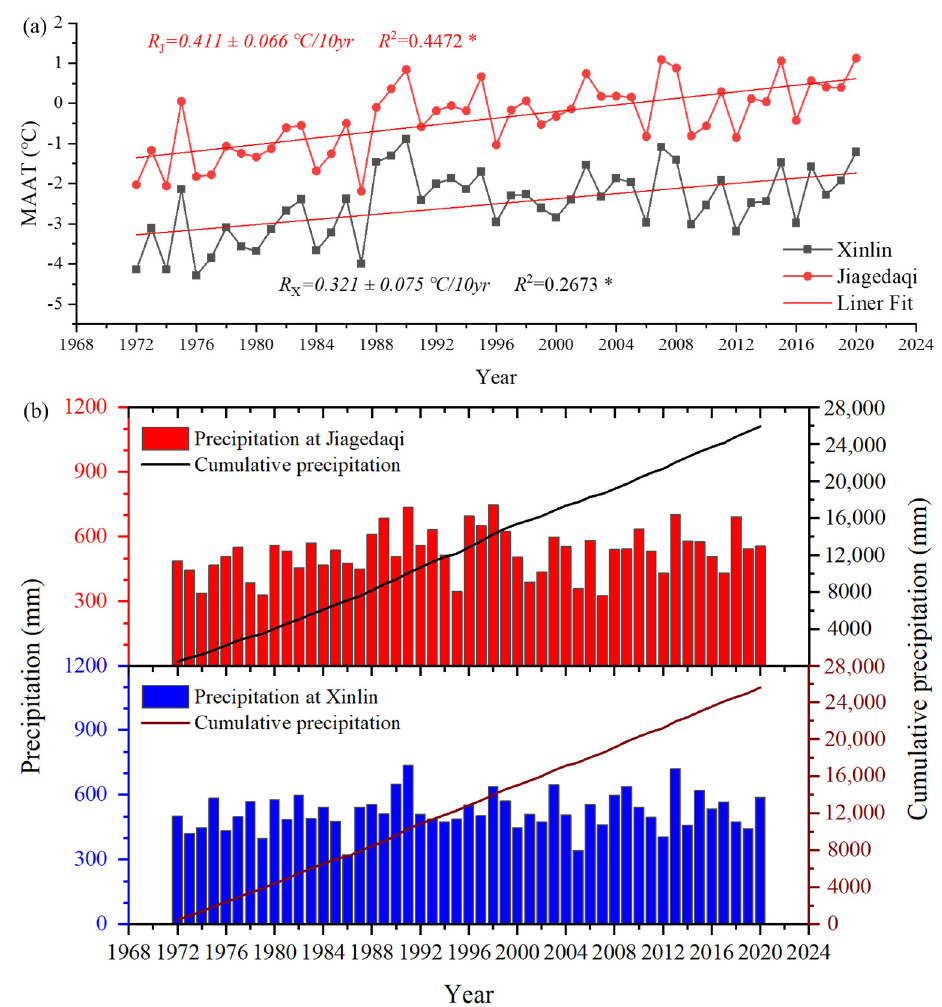
Figure 3. Variations of the ( a ) MAAT and ( b ) annual precipitation at the Xinlin and Jiagedaqi meteorological stations along the CRCOP in the northern Da Xing’anling Mountains, Northeast China, 1972–2020. R i : Rising rate, ( i = J, X); J represents Jiagedaqi; X represents Xinlin station.